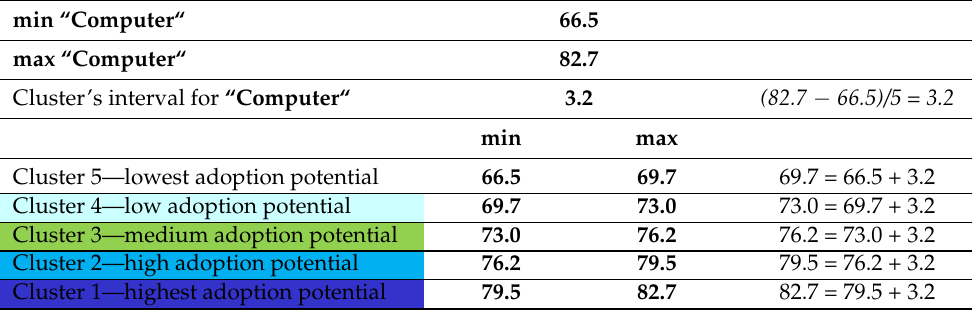
Table 12. Calculations for the “cluster interval” for variable “Computer“.